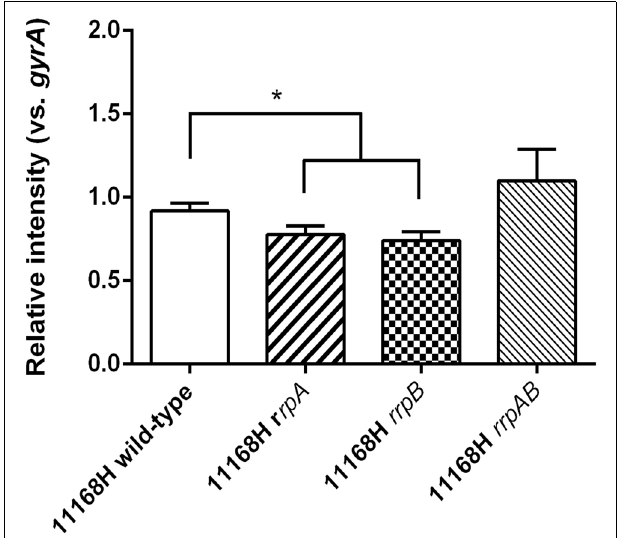
FIGURE 4 | RT-PCR analysis of katA transcription in C. jejuni 11168H wild-type strain and rrpA , rrpB , and rrpAB mutants. C. jejuni RNA was converted to cDNA and semi-quantitative levels of katA expression were measured as relative intensity to the internal control gyrA . Asterisks denote a statistically significant difference (* p <